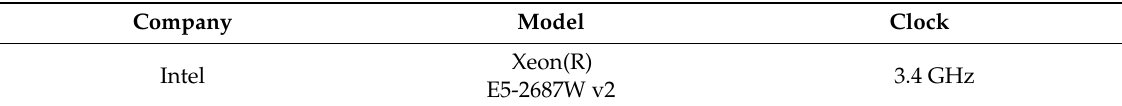
Table 4. The specifications of computer CPU.